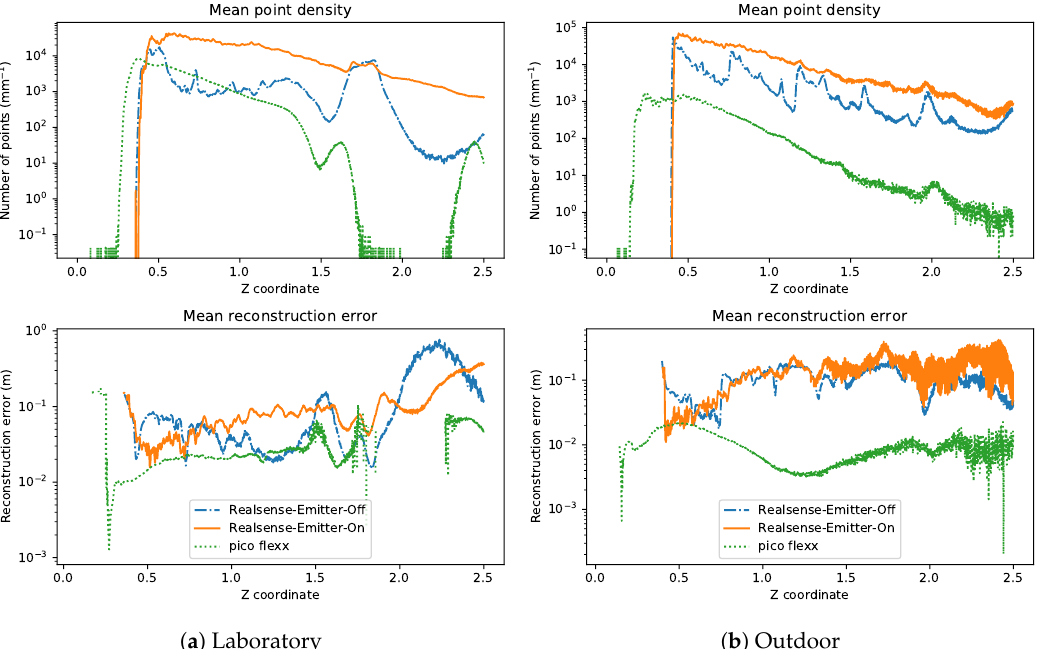
Figure 15. Mean point density and reconstruction error (cloud-to-mesh distance) with respect to the depth ( z ) coordinate of the